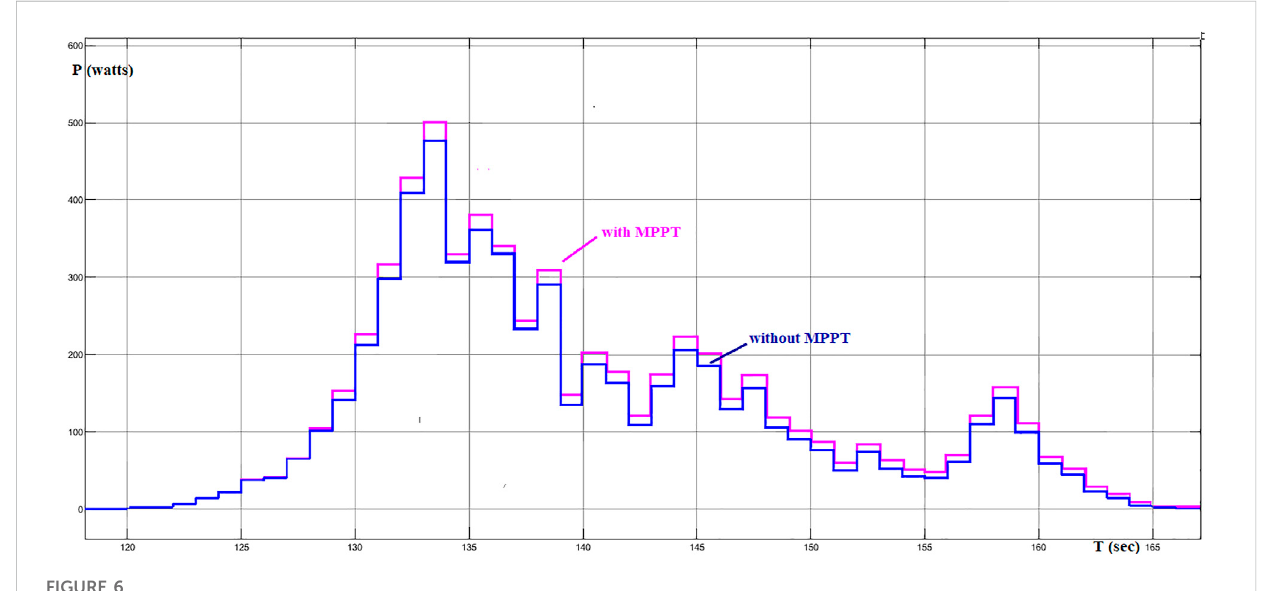
FIGURE 6 Simulated power output of solar panel (with and without MPPT).